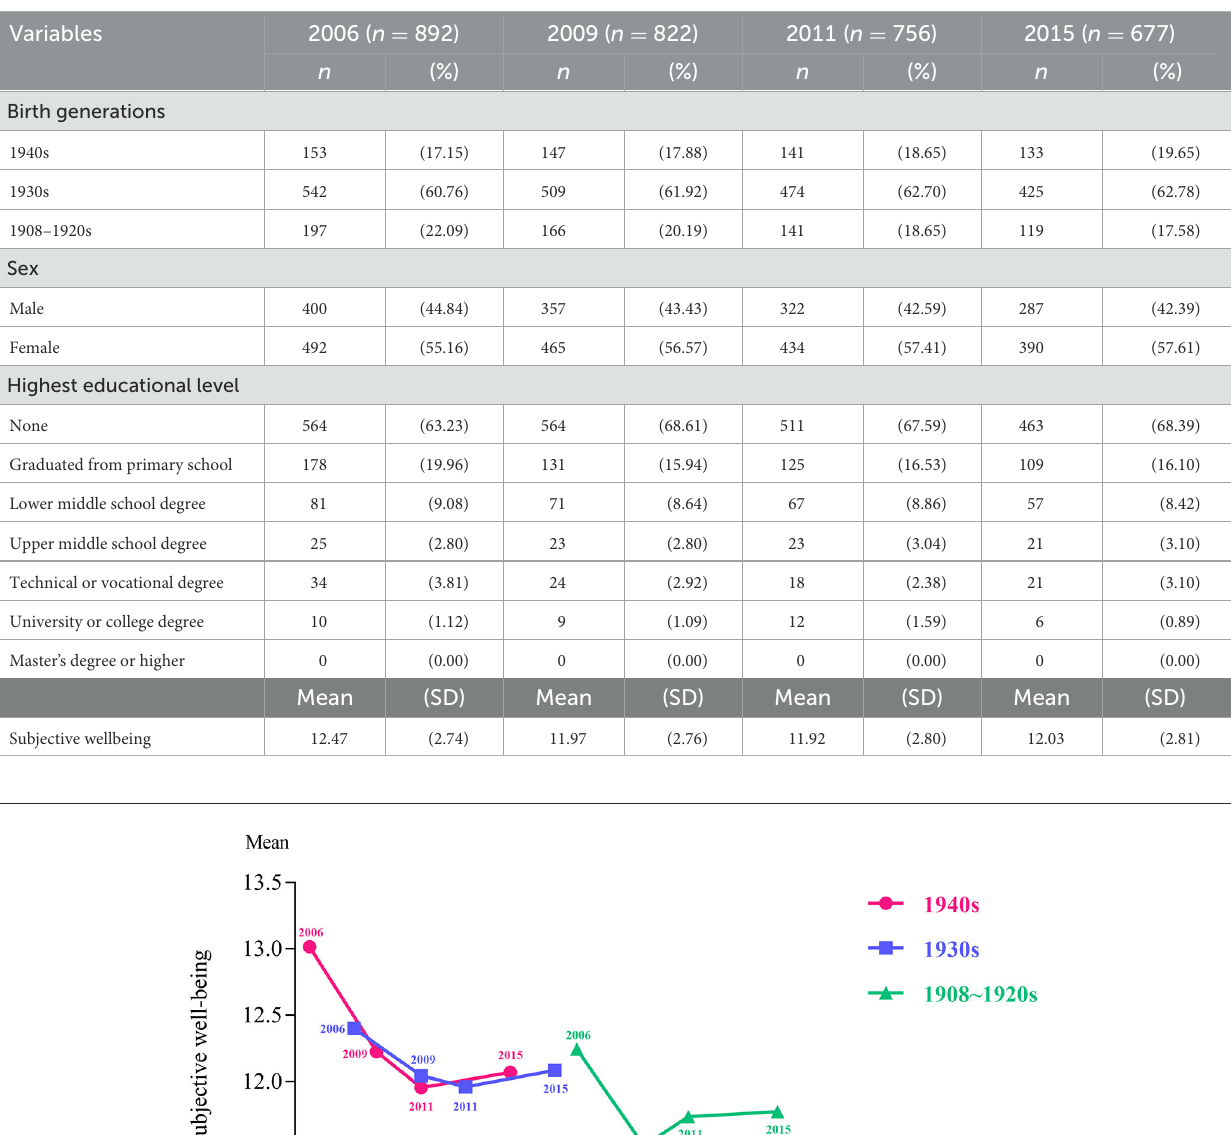
TABLE 1 Descriptive statistics of the follow-up sample.